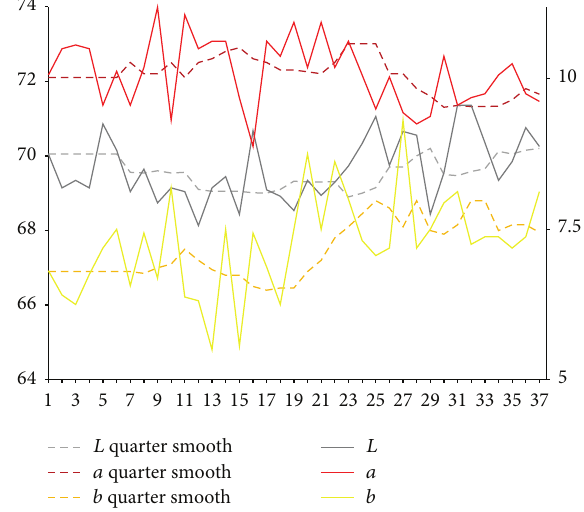
Table 4: Feature selection results by using HOML.